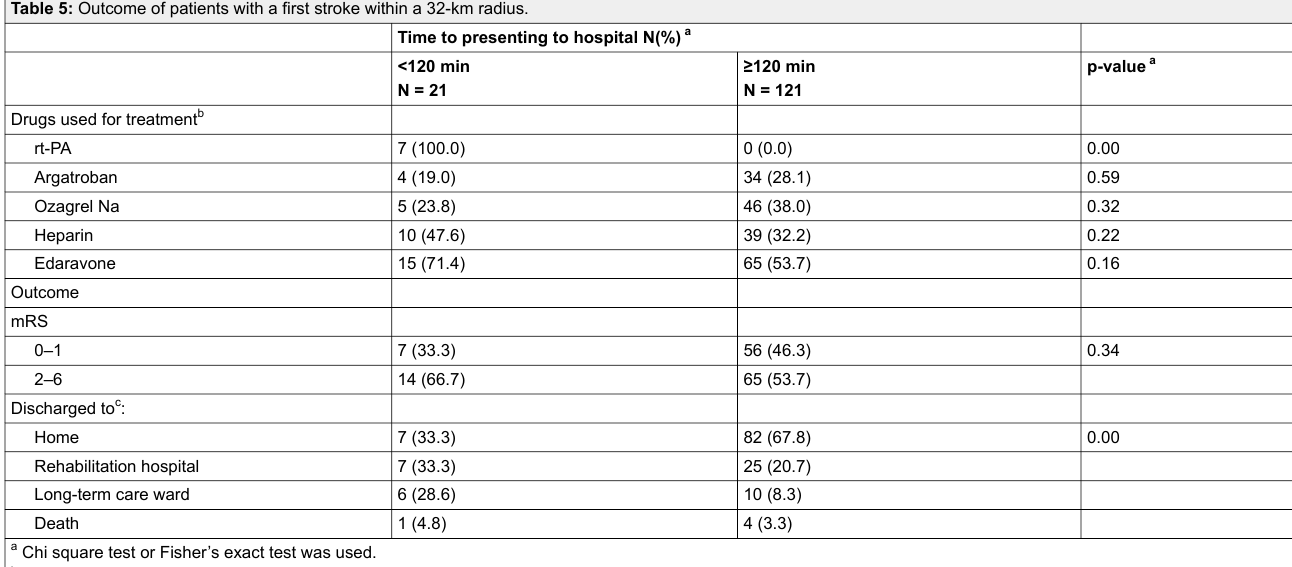
Table 5: Outcome of patients with a first stroke within a 32-km